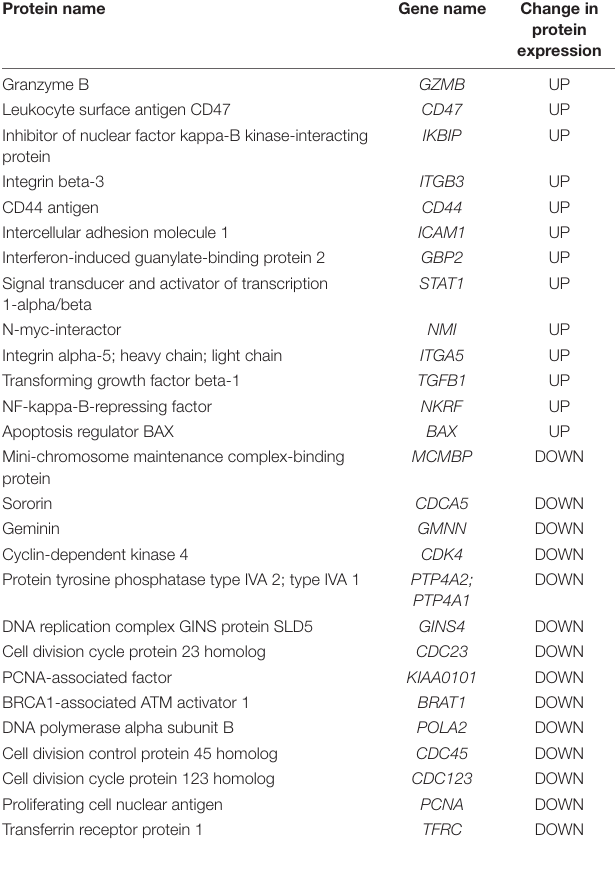
a list of selected, highly upregulated or downregulated proteins in NK3.3 EV-treated K562 cells when compared to HEK293 EV-treated cells. The full proteomic dataset is included in the supplement ( Supplementary Table 3 ).